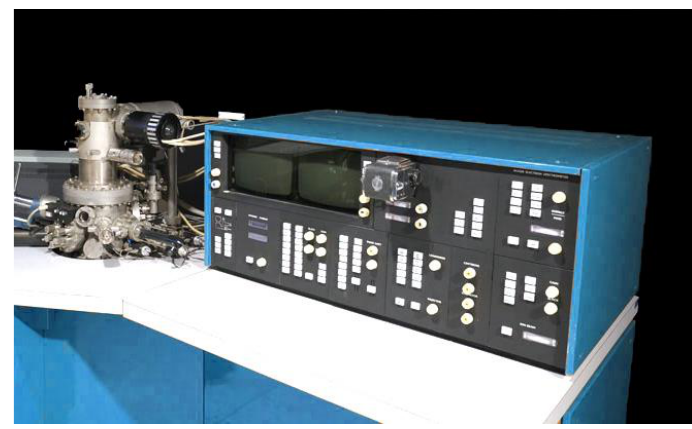
Figure 7. Electron microscope TESLA BC — 300.